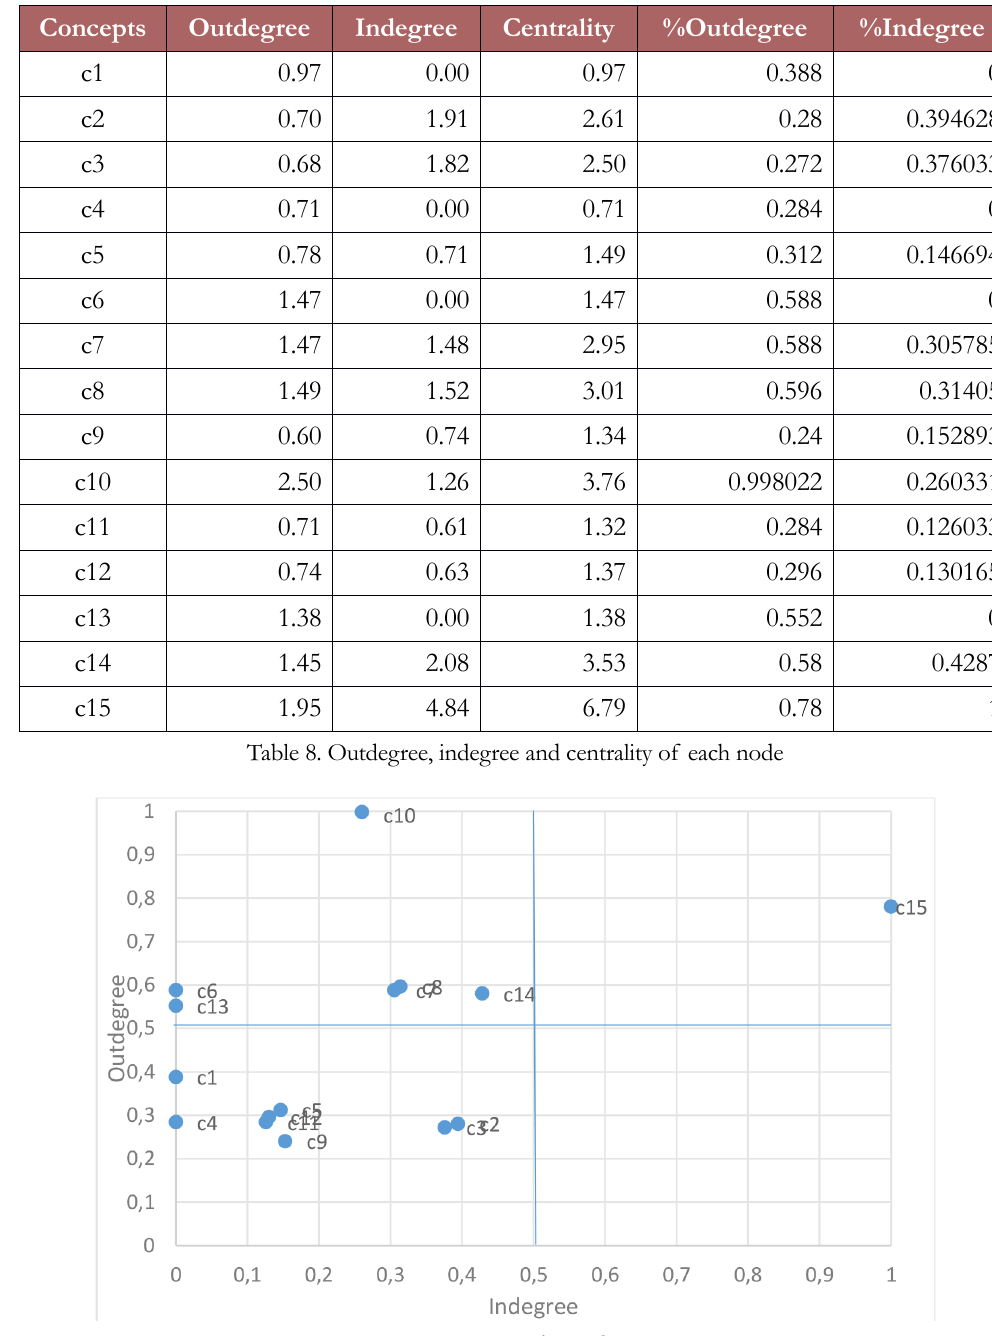
Figure 2. Grouping nodes in four